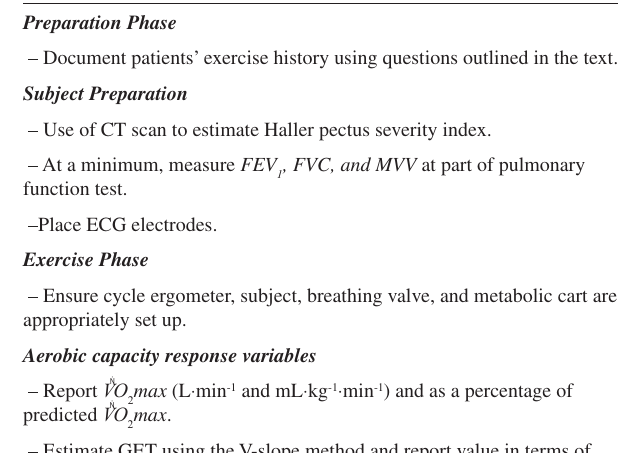
Table 1 - Step-by-step approach for CPET of pectus